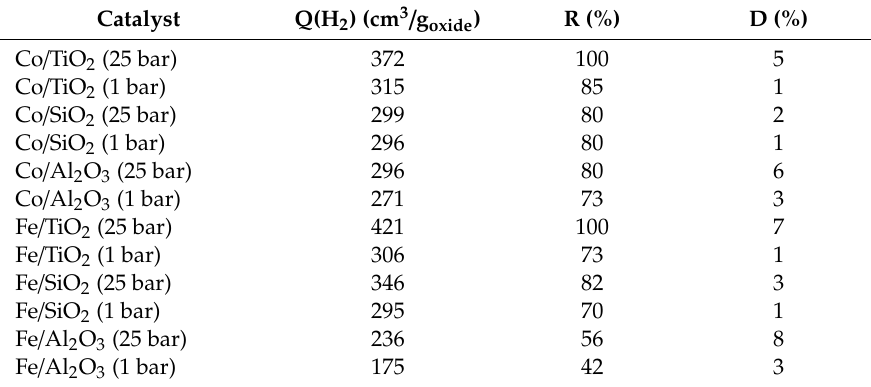
Table 2. Results of H 2 consumption, metal reducibility and